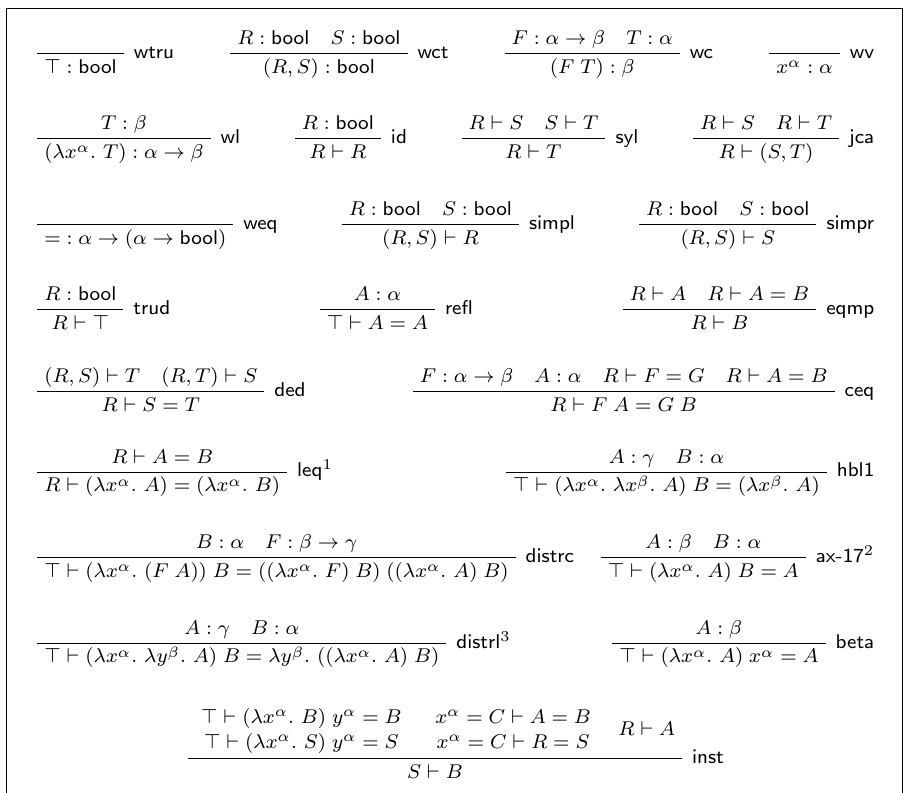
Fig. 2. The hol.mm